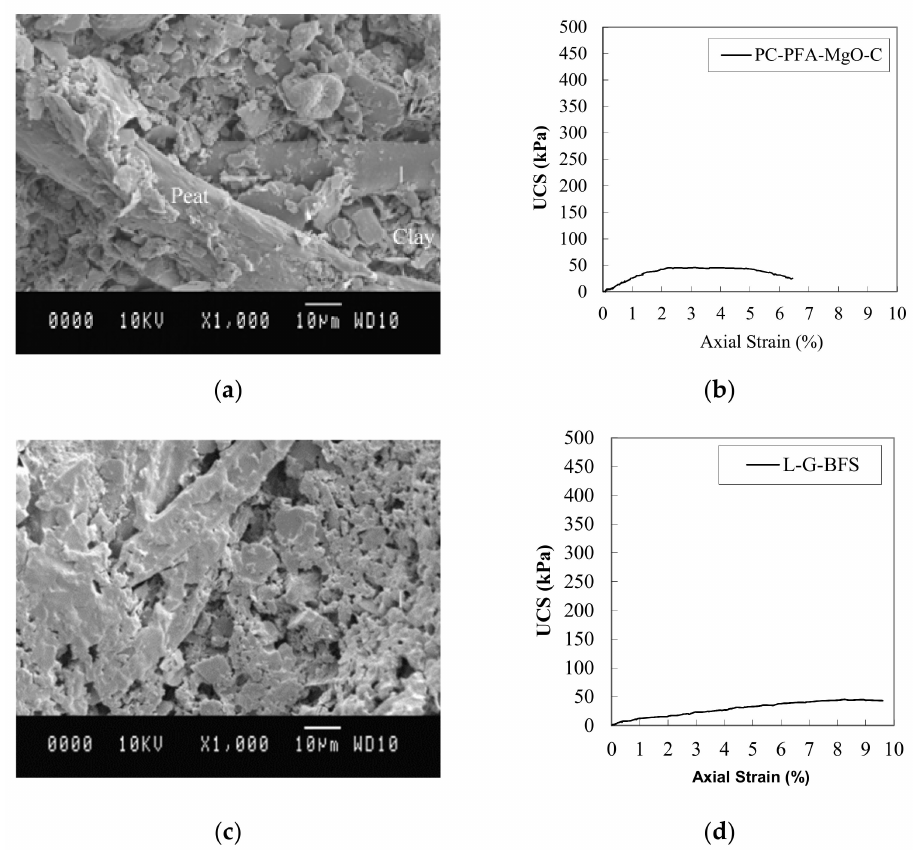
Figure 20. Stabilized OH-1 clay with 250kg/m 3 binder amount, 28 days curing time: ( a , b ) OH-1-PC-PFA-MgO-C and ( c , d ) OH-1 -